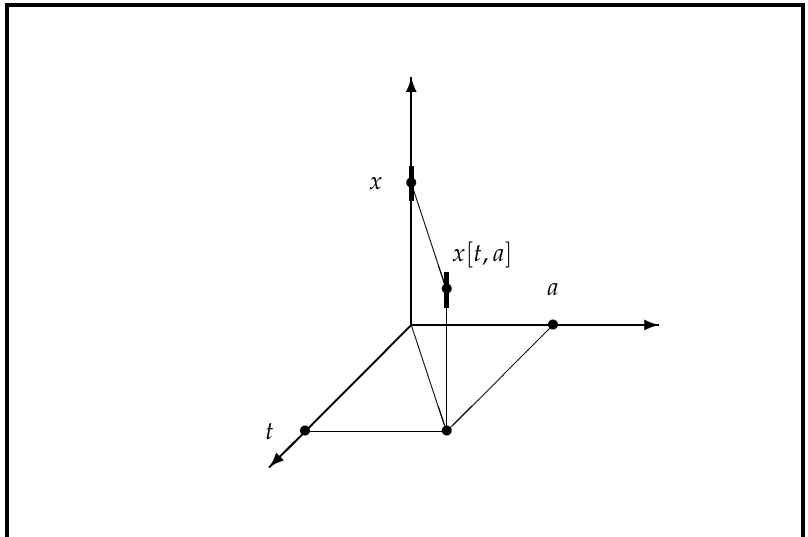
Figure 10. Neighborhood of a point in the topological space. Source: Own elaboration.